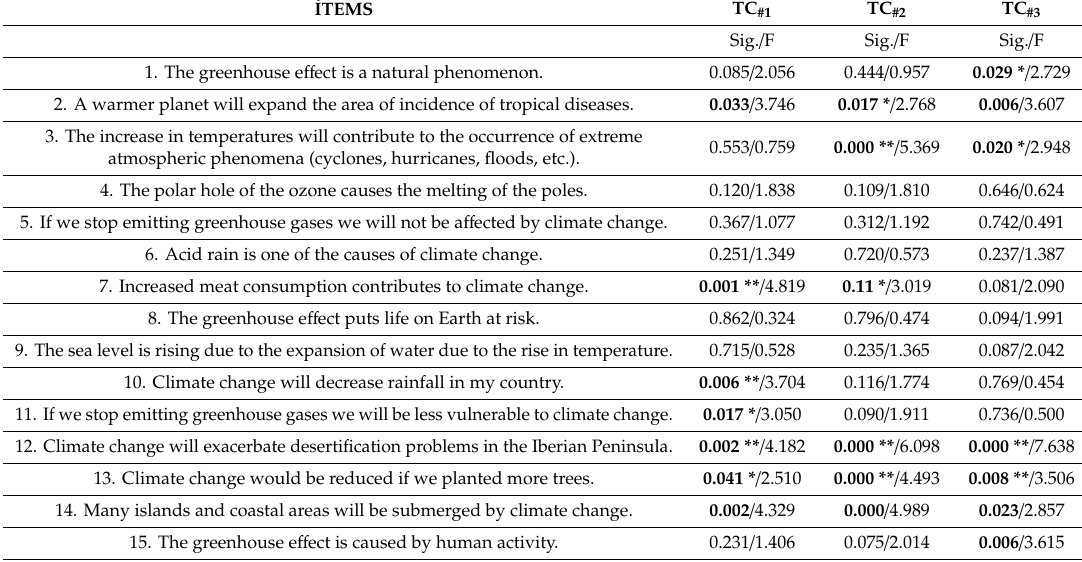
Table 15. Assess your degree of pro-environmental